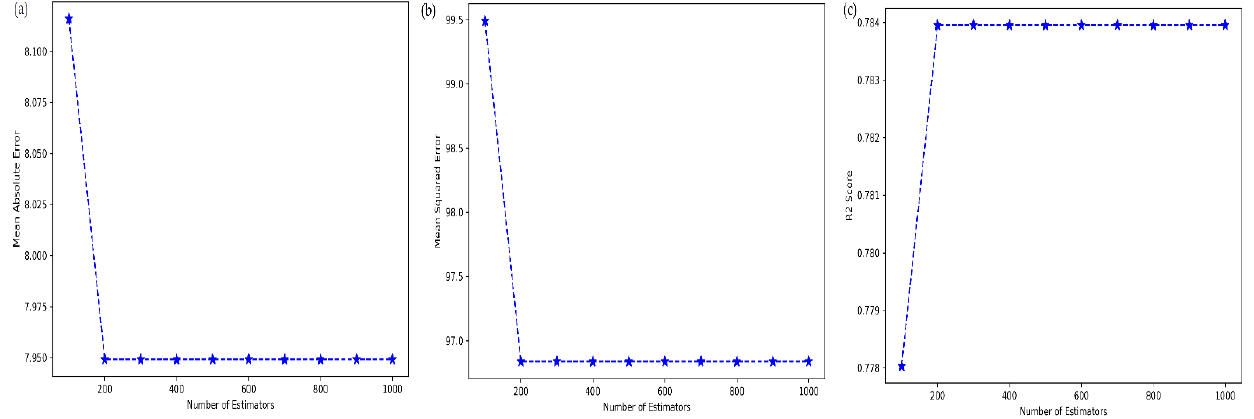
Figure 3. Effect of number of estimators on random forest regression’s performance in terms of ( a ) . MAE, ( b ) MSE and ( c ) 2 𝑅𝑅